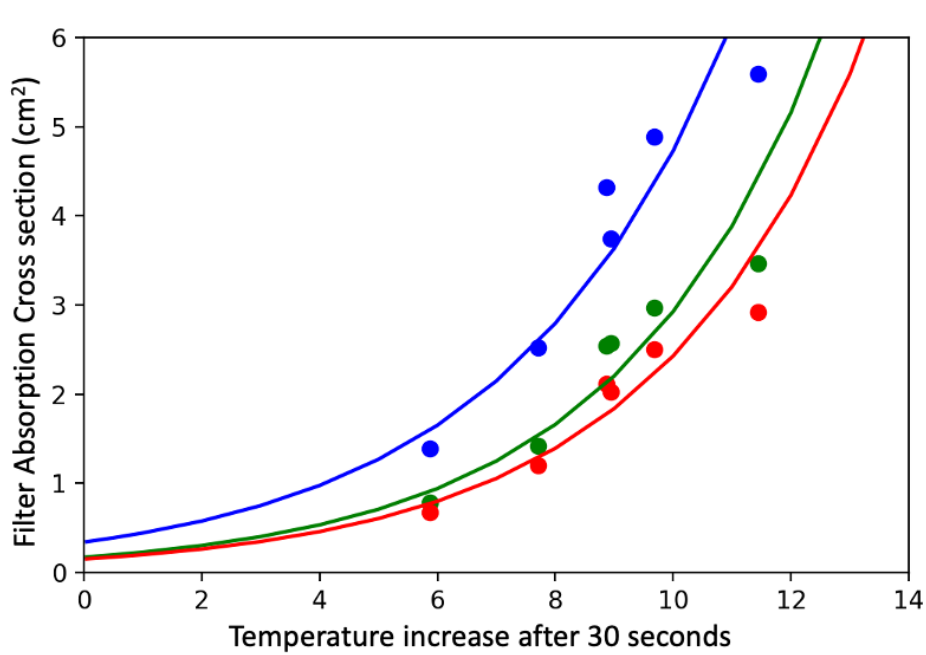
Figure 6. LAHM T corr plotted versus the filter absorption cross section deduced from collocated photoacoustic measurements of the spectral absorption coefficient for Karlsruhe ambient air. The individual wavelengths of the PAAS instrument are represented in blue (405 nm), green (532 nm), and red (658 nm).